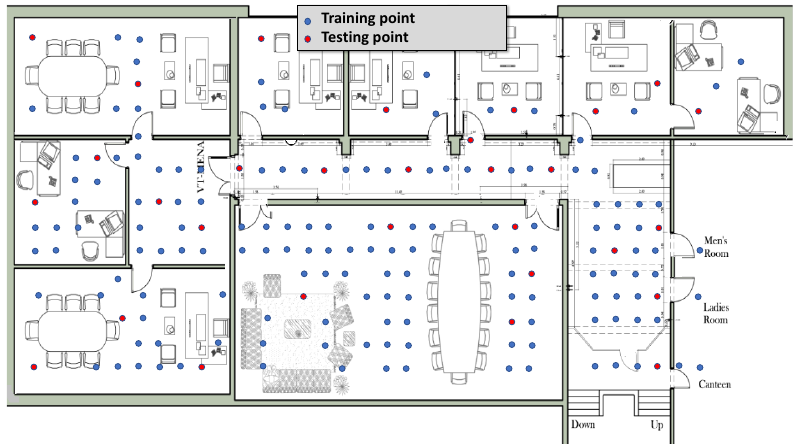
Figure 5. Layout of Lab testbed. Blue and red circles represent training and testing points, respectively.